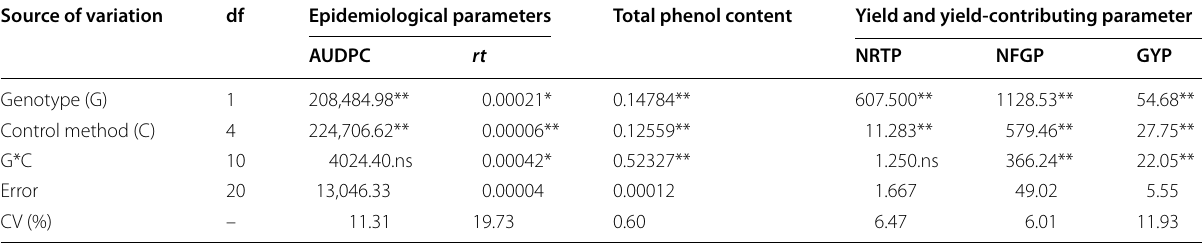
df degree of freedom, AUDPC = of filled grain per panicle,